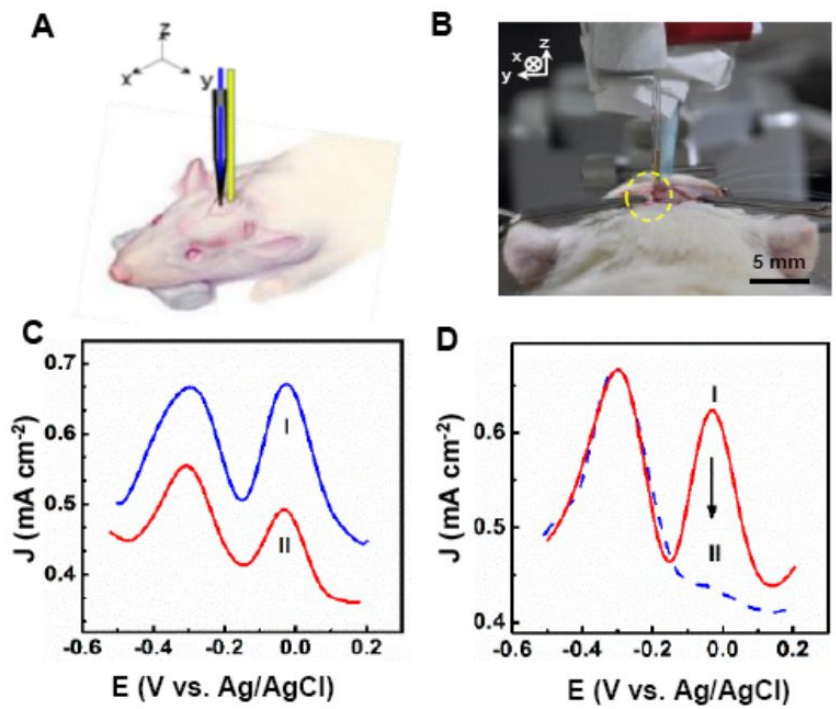
Figure 5. ( A ) Schematic illustration of the in vivo setup for determining AA in rat brain. ( B ) Optical images before and after the stereotaxic implant into the brain. ( C ) DPVs recorded at the e − CNF microelectrode in the striatum of a normal rat (I) and the rat brain model of AD (II). ( D ) DPV responses recorded at the e − CNF microelectrode in the striatum of the rat brain model of AD before (I) and after (II) injection of ascorbate oxidase. Reproduced with permission from [23]. Copyright 2017 American Chemical Society.